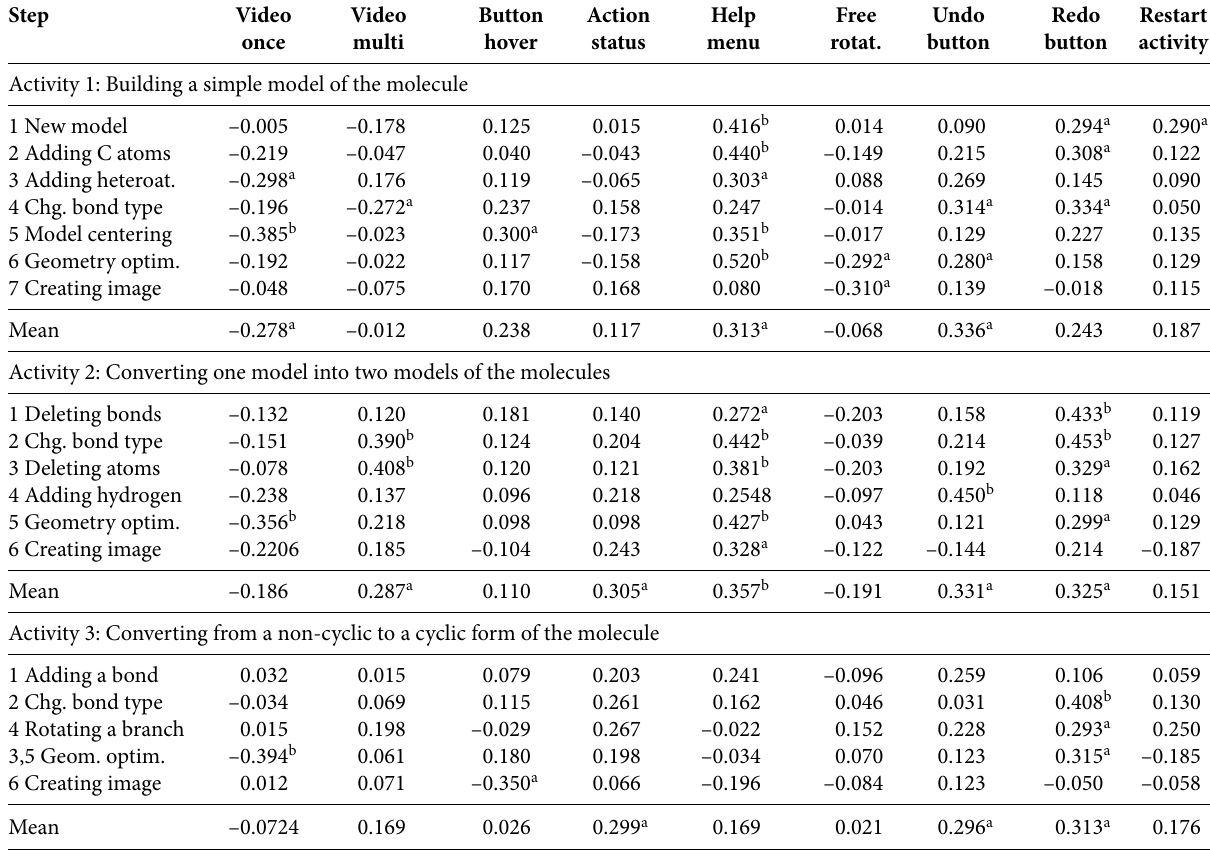
Table 17: Spearman correlations between use of help tools and step difficulty level